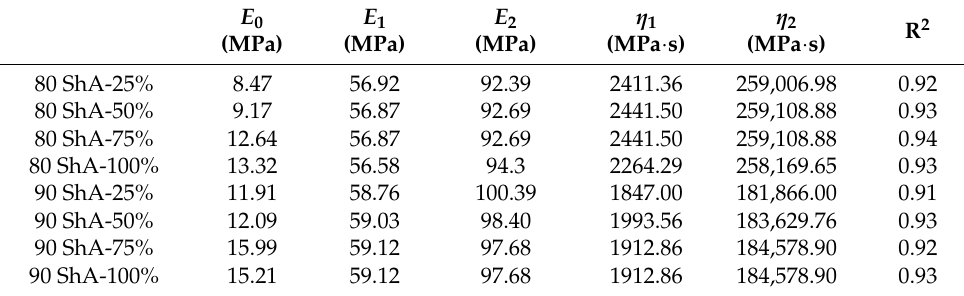
Table 2. Stress relaxation model material data for 80 ShA and 90 ShA.